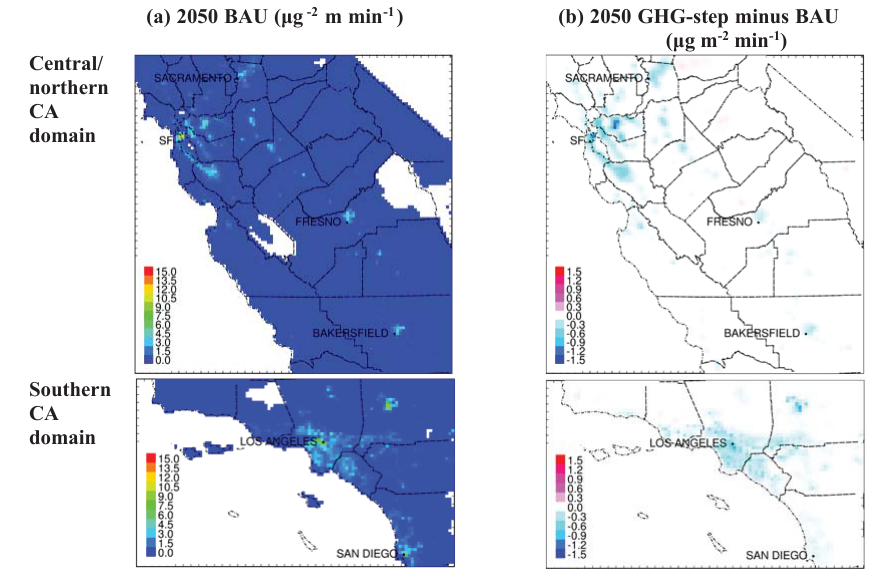
Figure 15. Particulate matter emissions from residential and commercial sources in the BAU scenario (a) and emissions change in the GHG-Step scenario (b) . Units are µgm − 2 min − 1